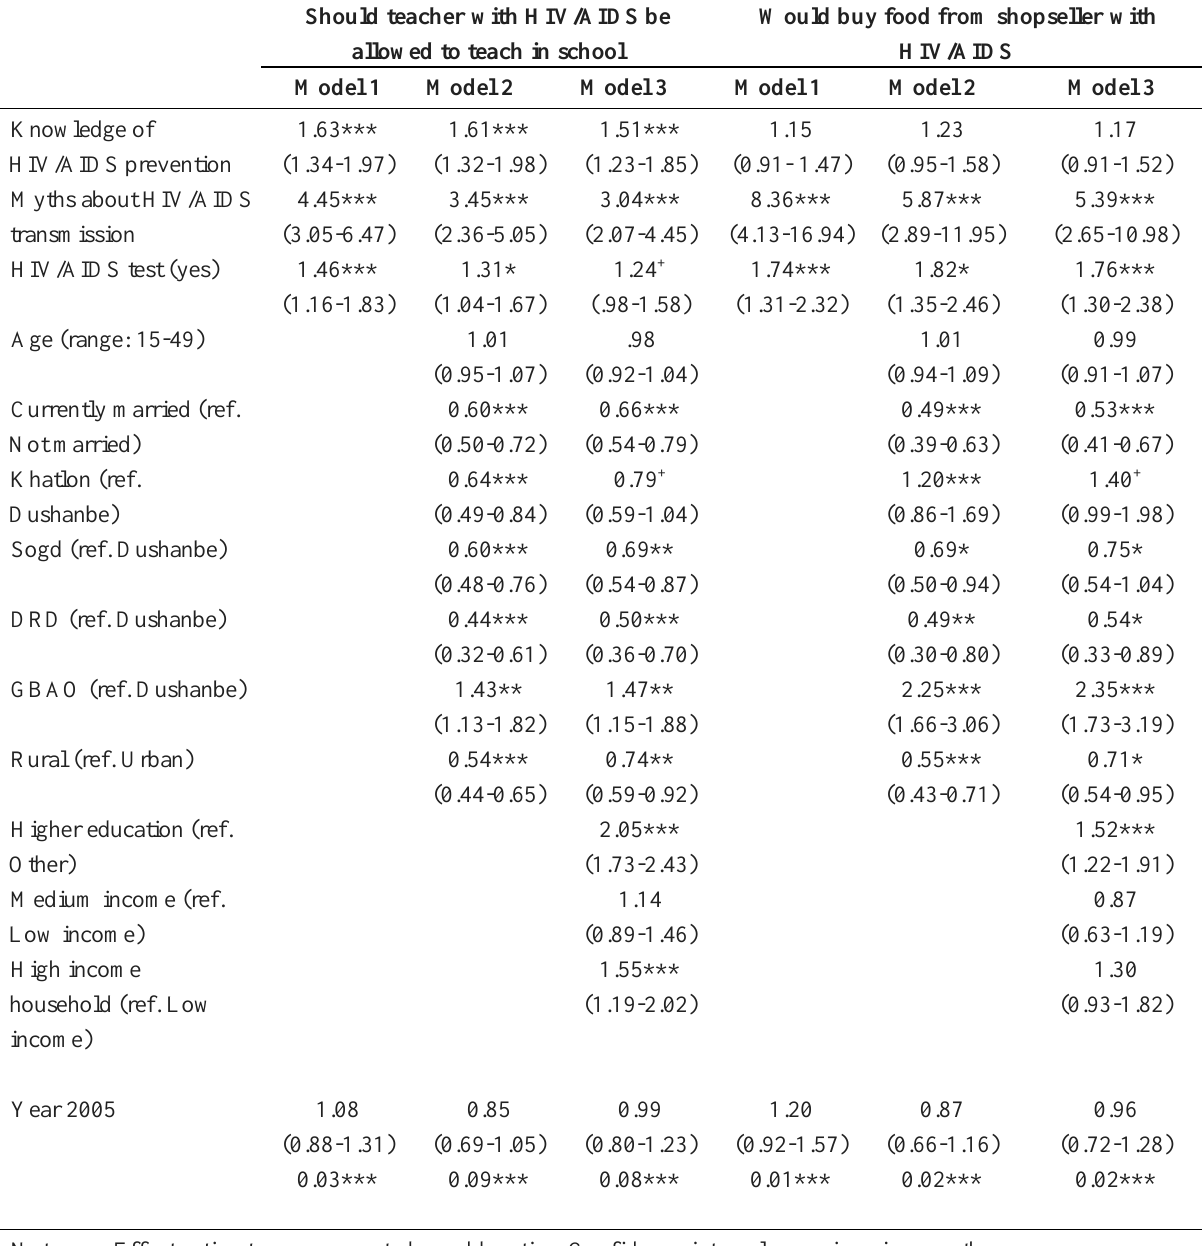
Table 2. Binary logistic regression predicting positive attitudes towards people living with HIV/AIDS, MICS 2000,